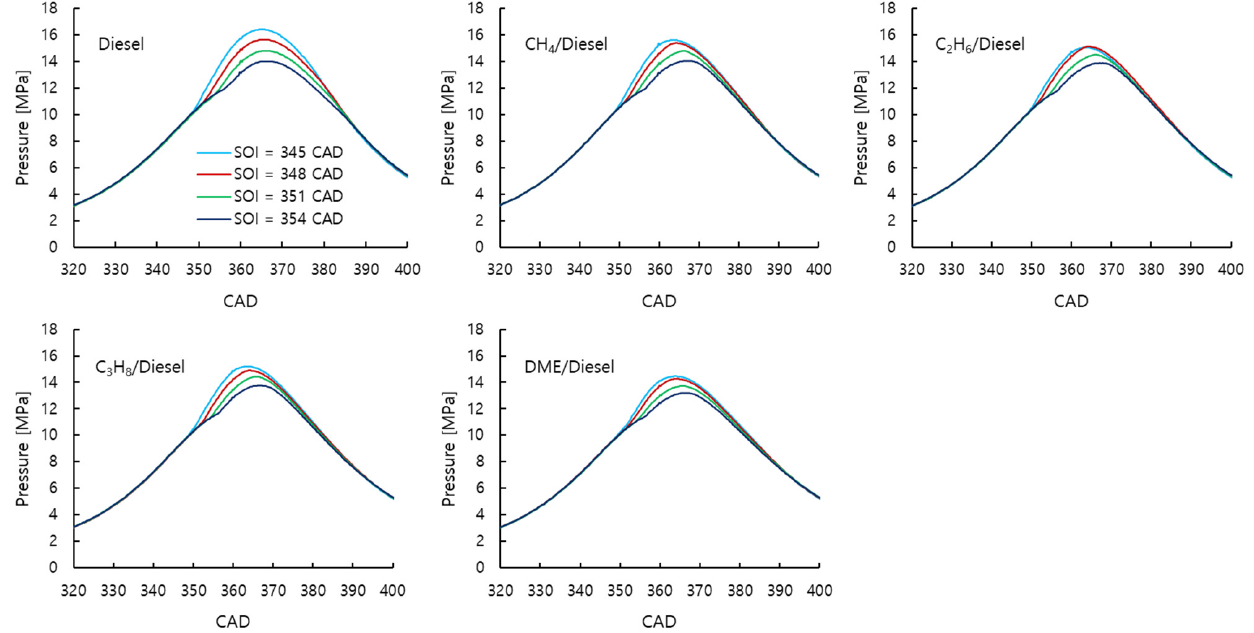
Figure 19. In-cylinder pressure diagrams according to pilot SOI angles in all combustion modes